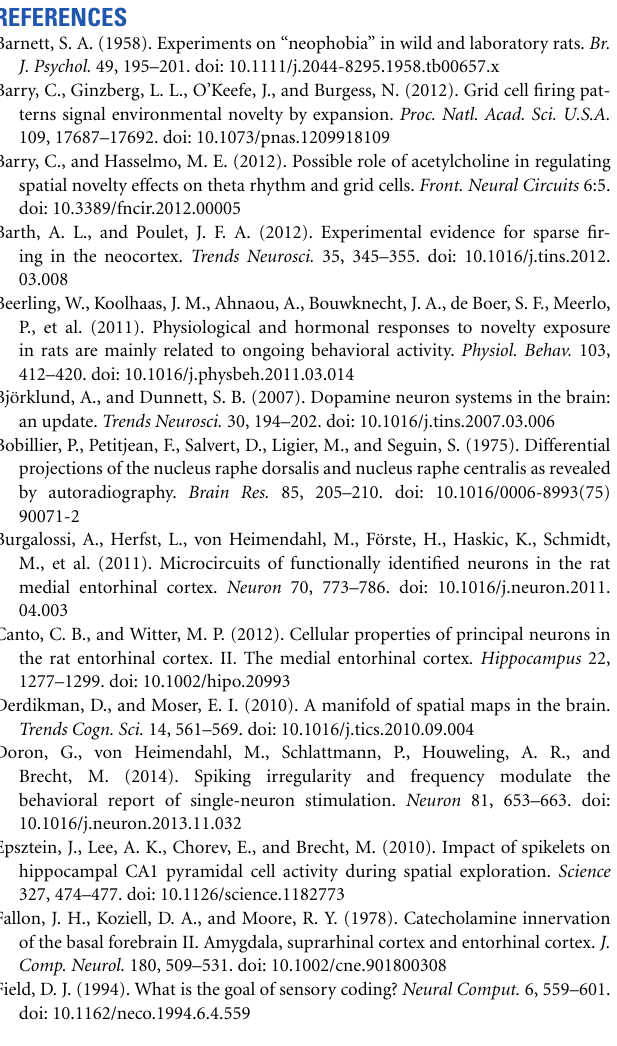
Figure S1 | Rats’ behavior indicates novelty detection. (A) Per-rat mean speed during exploration of either a novel or a familiar O-maze. (B) As in (A) , but for rats in the two-compartment maze. (C) For rats in the novel environment of the two-compartment maze, share of time spent in the central quarter of the maze. The red line indicates the expected share assuming a uniform sampling of the space by the rat. (D) In the two-compartment maze, share of time spent in the familiar environment after first entering it. The red line indicates indifferent choice (50%). Figure S2 | Distribution of neuronal firing rates in medial entorhinal cortex. (A) Firing rate histogram for all cells ( n = 70). To better resolve low firing rates all cells were assigned an extra virtual spike, leading to different rates for a recording without observed spikes of, e.g., 10s (rate 1 · 10 − 1 Hz) as opposed to 10min (rate 0 . 2 · 10 − 2 Hz) (see Materials and Methods). (B) Firing rate histograms as in (A) , but for superficial (light blue; n = 33) and deep layer cells (dark blue, n =